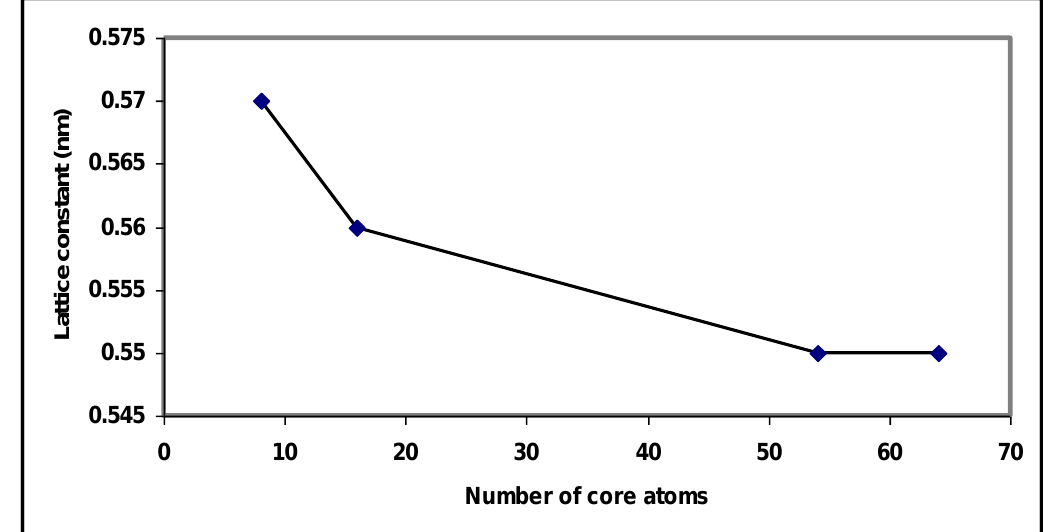
11.522.533.544.5